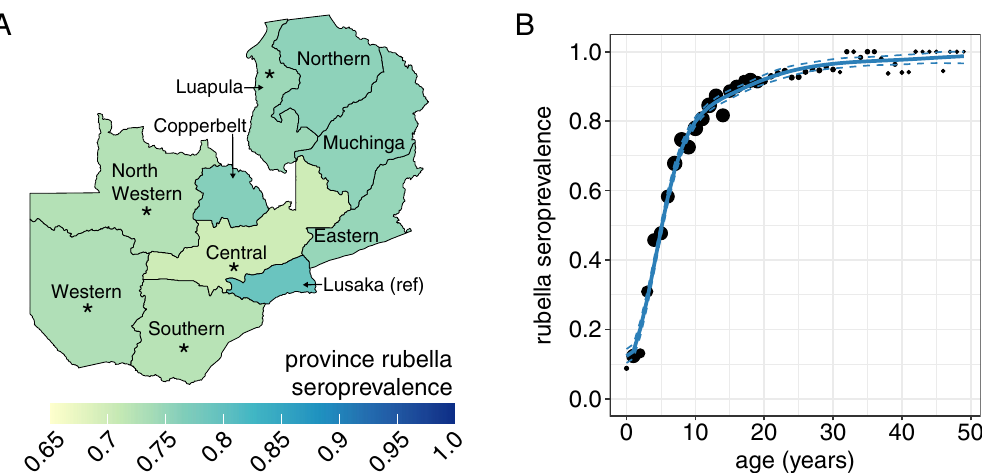
Figure 4. Rubella seroprevalence. ( A ) Province seroprevalence. The asterisks represent provinces that had significantly different seroprevalence than the reference province, Lusaka Province (0.05 alpha level). ( B ) National age-specific seroprevalence. The points represent the data grouped by age in years with the exception of year 0 which includes only individuals 10 and 11 months old and the size of the point is proportional to the number of observations in each age group (seroprevalence estimates for individuals younger than 10 months was collected and is show in Fig. S8). The blue lines represent fitted generalized additive model mean (solid line) and 95% confidence intervals (dashed lines). Rubella vaccine was not available in the public sector prior to the